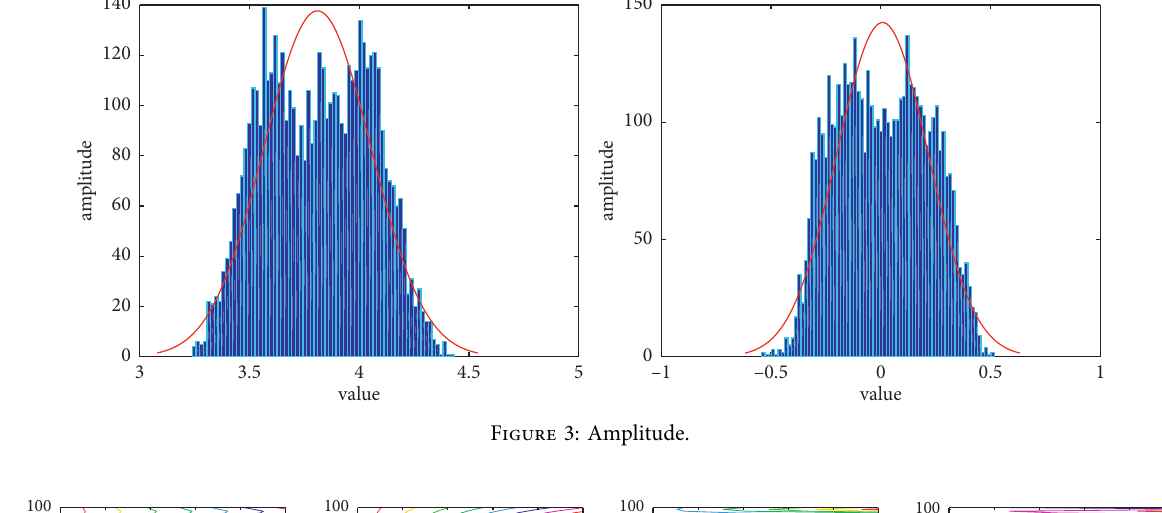
Figure 3: Amplitude.